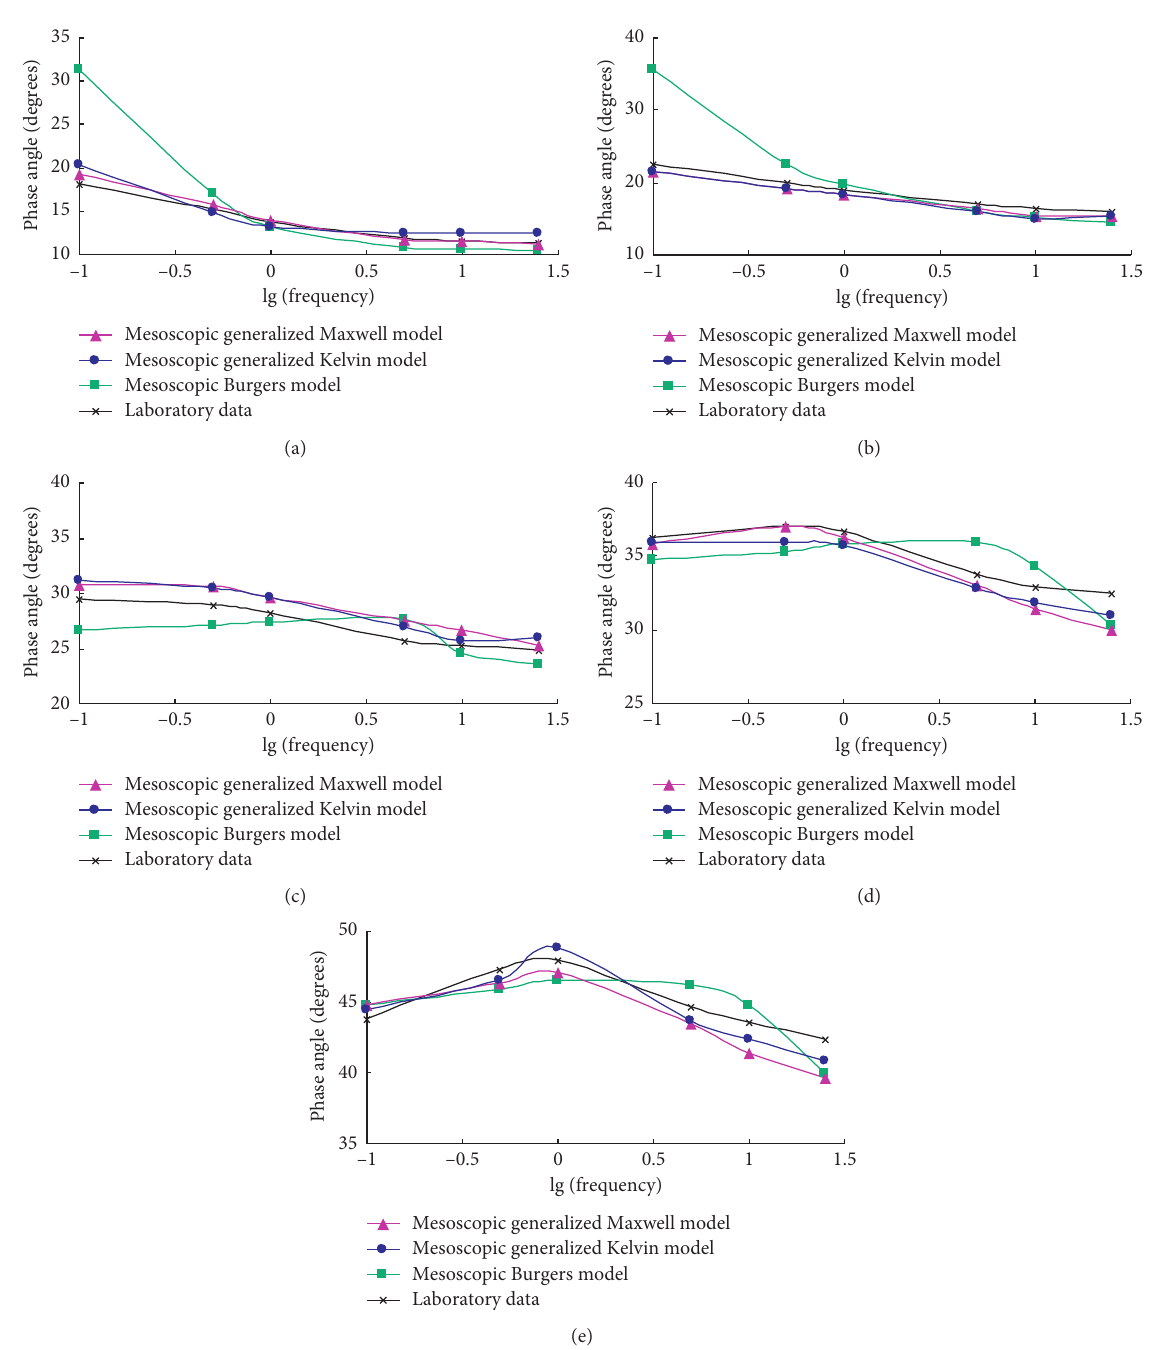
Figure 12: Laboratory data and simulation results of phase angle. (a) − 6 ° C. (b) 4 ° C. (c) 16 ° C. (d) 27 ° C. (e) 38 °